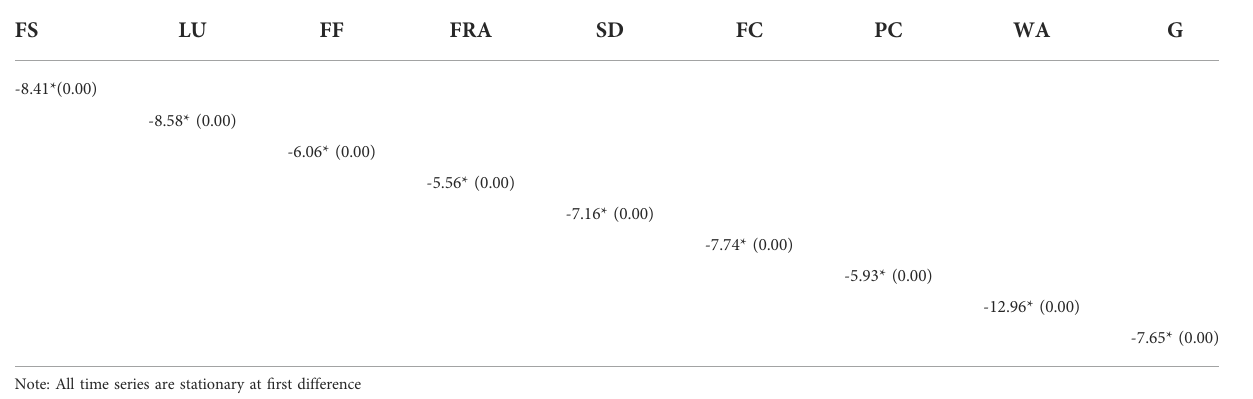
Note: All time series are stationary at fi rst